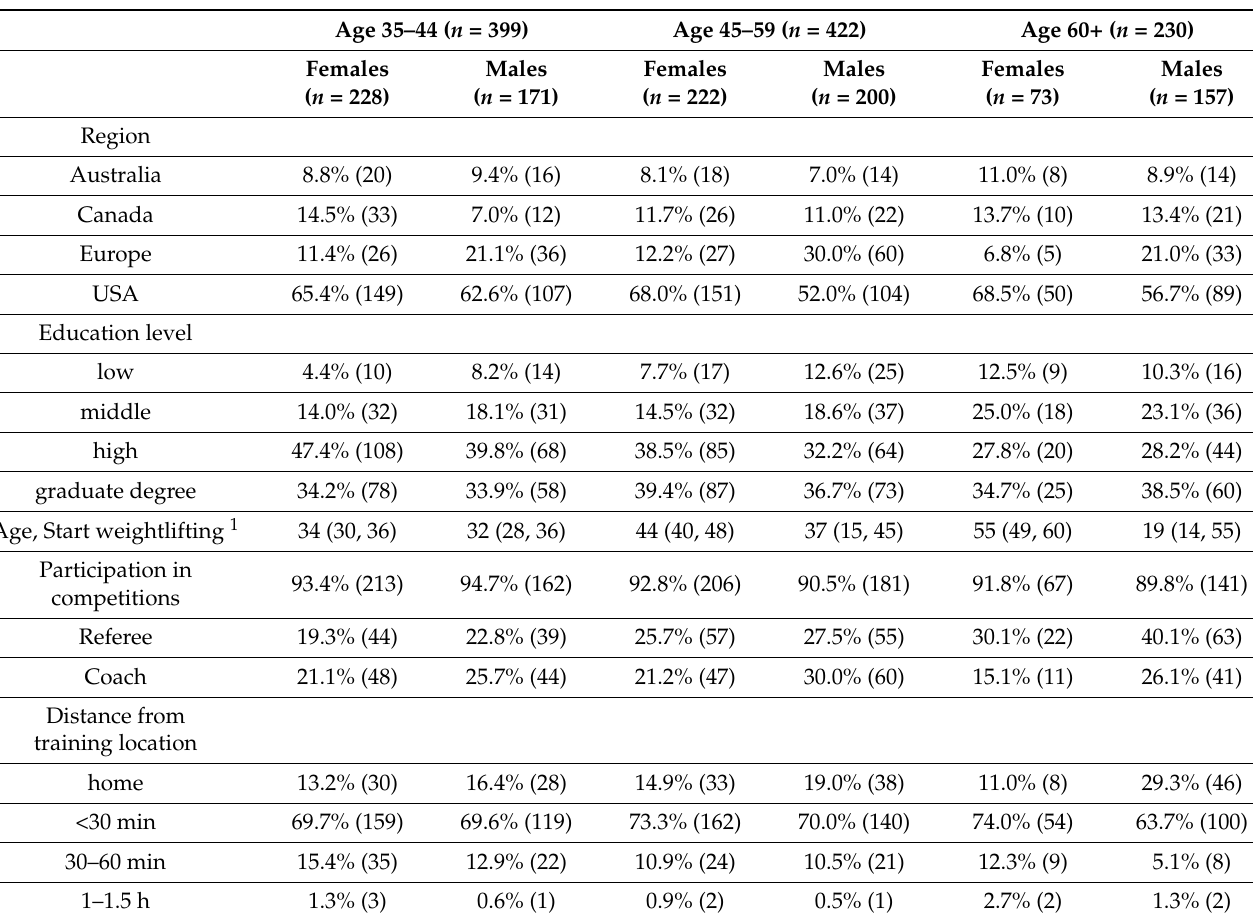
Table 1. Demographics by age and